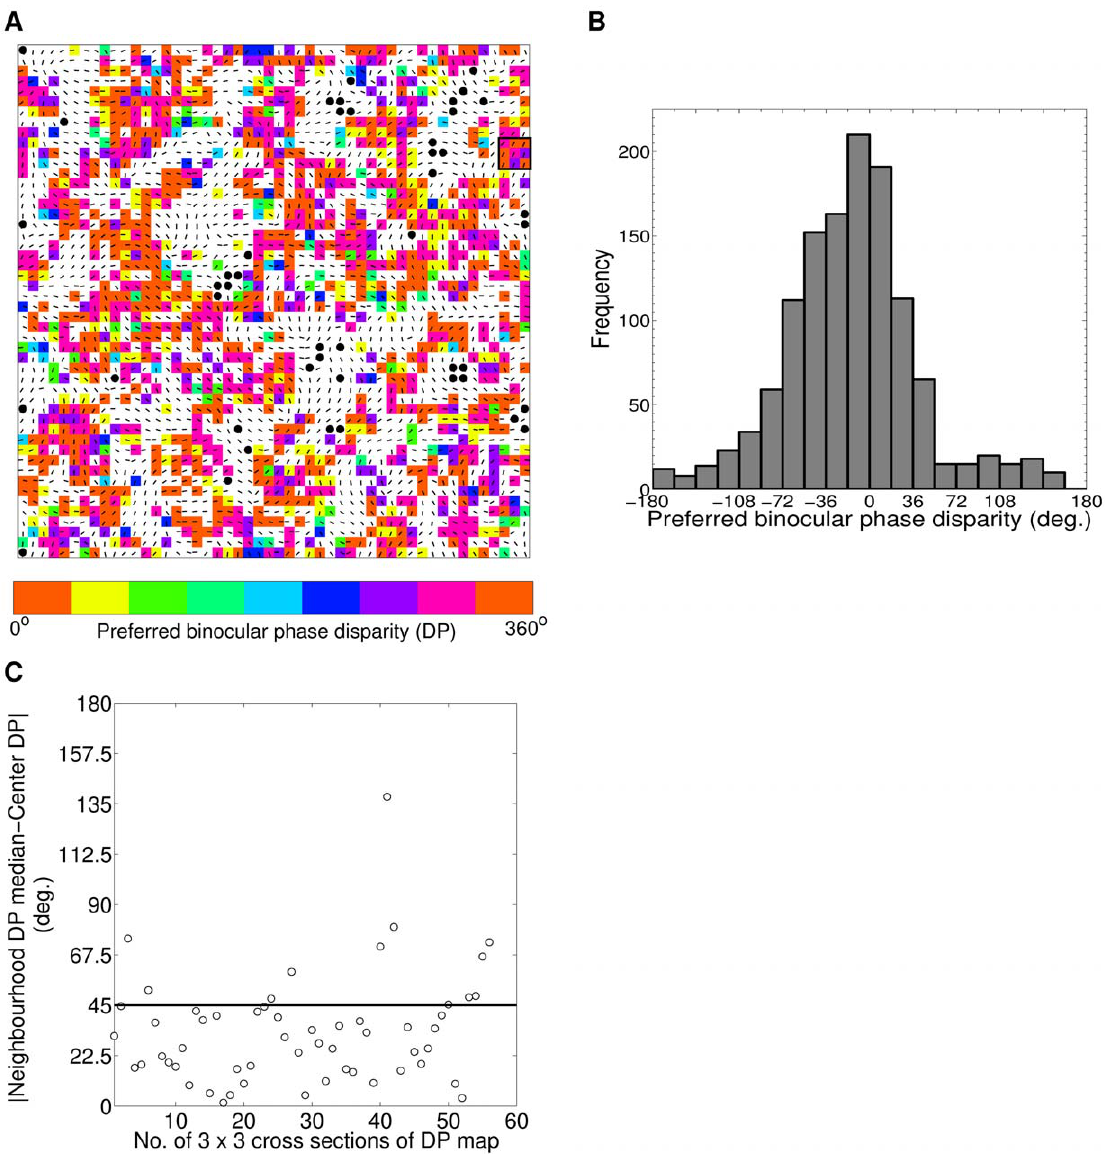
Figure 8. Disparity map and its organization. (A) Disparity map using color code scheme in 0 to 360 scale. The black color filled circles represents cortical cells with DSen¡0.3. The white color cells are Dif-frequency disparity selective cells. The superimposed oriented black color bars depict binocular preferred OR for cells in the map. (B) Histogram of DP across the model cortex in 2 180 to 180 scale. (C) Here we explored the smoothness of the topographic organization of DP by finding similarity/smoothness in 3 6 3 neighborhoods in DP map. A sample 3 6 3 section of DP map is shown in Figure 8A marked with black square boundary. Figure 8C depicts the difference between neighborhood median DP and center DP for 56 possible 3 6 3 sections from our DP map. In 45 out of total 56 possible 3 6 3 sections difference is # 45 u threshold difference. This result suggests that DP values in disparity map are weakly clustered together.